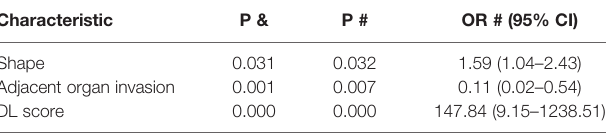
TABLE 3 | Signi fi cant correlations of MG with semantic CT imaging features and DL score using Logistic Regression Forward Stepwise ( Likelihood Ratio ) method. Characteristic